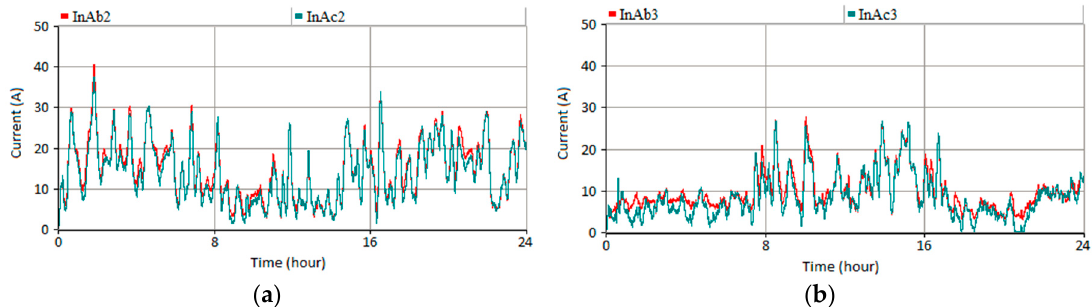
Figure 14. MGG dynamic NCC + sharing performance comparing case Ac and case Ab for: ( a ) MG2; ( b ) MG3.